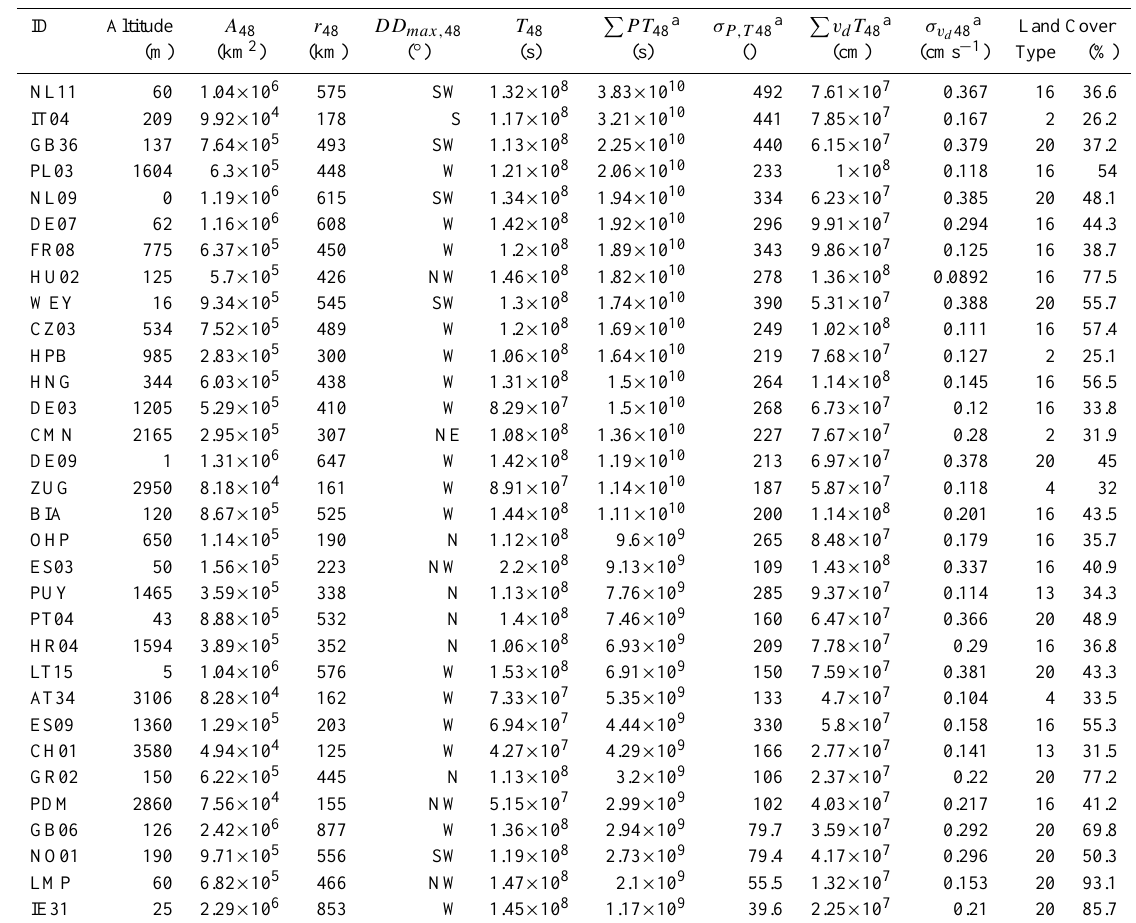
Table 2c. Same as Table 2a but for 48h catchment